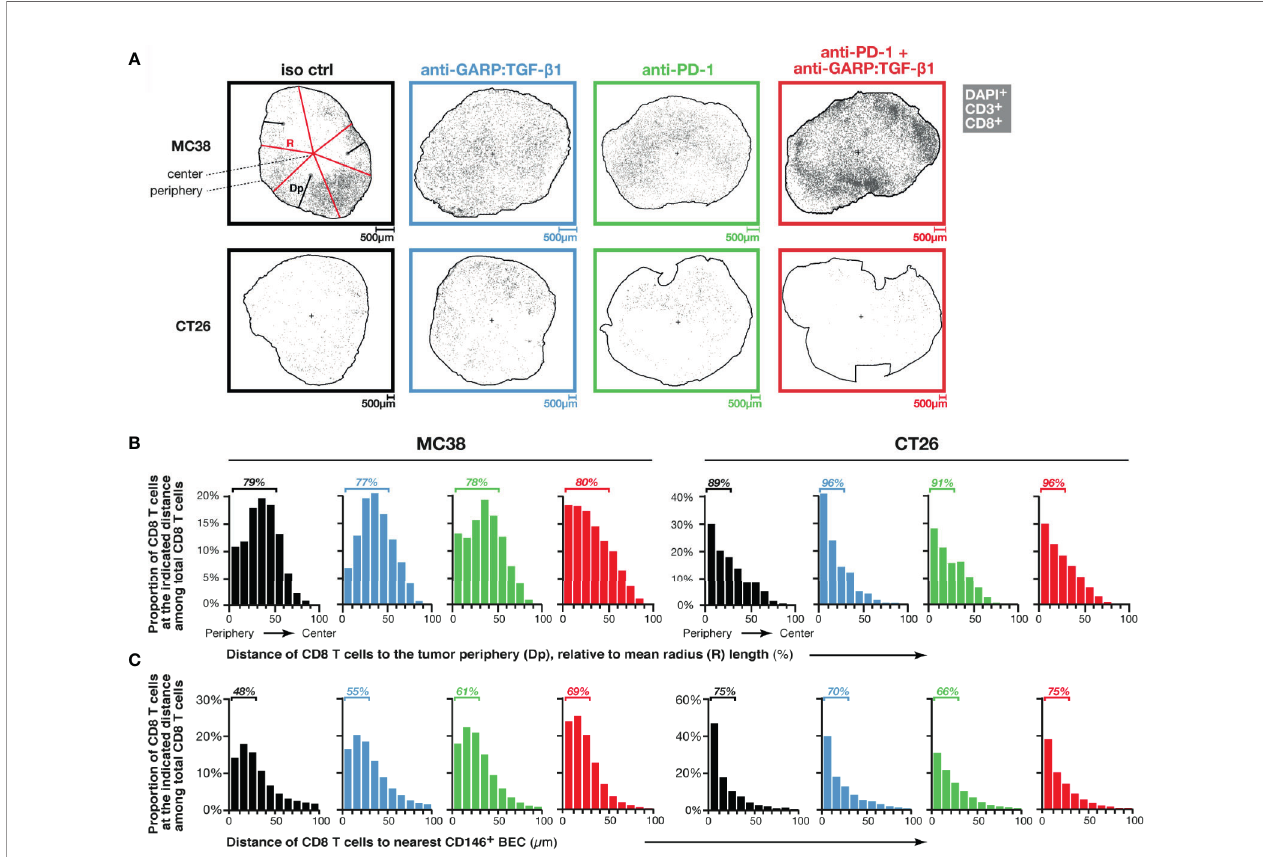
FIGURE 2 | Combined GARP:TGF- b 1/PD-1 blockade induces entry of T cells via intratumoral vessels rather than penetration from the tumor periphery. Sections of FFPE tumors from Figures 1A, B analyzed by mIF and quantitative digital imaging. Treatment groups are indicated in colored font on top (black: isotype control; blue: anti-GARP:TGF- b 1; green: anti-PD-1; red: anti-PD-1 + anti-GARP:TGF- b 1). (A) Digital representations generated by the Halo software of one representative tumor section per treatment group, with CD8 T cells (DAPI + CD3 + CD8 + ) indicated as grey dots. The outer edge of the tumors (periphery) is delineated by a black line, and the position of the tumor center, calculated as a centroid, is depicted by a black cross. On one representative section (top left), the distance to the periphery (Dp) of a few CD8 T cells are illustrated by black lines, and a few radiuses (R) are depicted by red lines. A mean radius length was calculated for each section based on the lengths of all radiuses measured in the section (one radius represents the distance between the centroid and one DAPI + nucleus located on the tumor periphery). (B) Distribution of Dp of CD8 T cells relative to mean radius length, i.e. proportion of CD8 T cells within all CD8 T cells in a given tumor section that are located at the indicated relative Dp (0 – 10%, 10 – 20%, … ). Bars represent mean proportions in all sections analyzed in one treatment group. (C) Distribution of CD8 T cell distances to the nearest endothelial cell (DAPI + CD146 + ), as determined using nearest neighbor analysis. Bars represent mean proportions of CD8 T cells within all CD8 T cells in a given section that are located at the indicated distance (0 – 10 µm, 10 – 20 µm, … ) from the nearest blood endothelial cell (BEC). Results from one experiment for MC38 (n = 5 – 6 mice/group) and pooled from two independent experiments for CT26 (n = 3 – 6 mice/group in each experiment). One tumor section analyzed per